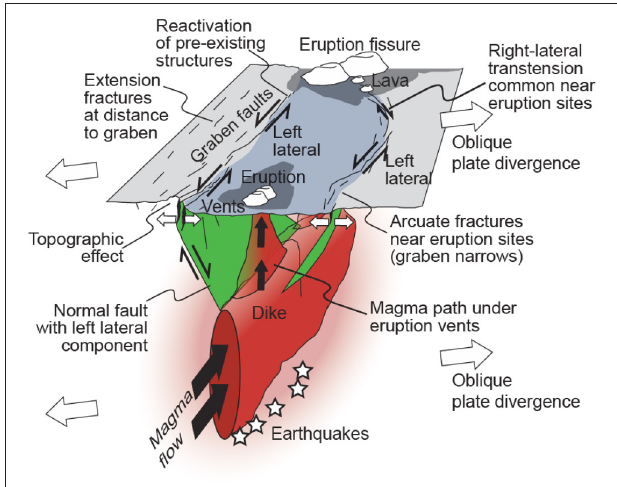
FIGURE 9 | Sketch illustrating the structural relations at the Holuhraun eruption sites. Graben subsidence is identified above the feeder dike (red color), and delimited by graben faults (green color) and smaller fractures at distance (black lines). At the surface, the graben faults show transtensional dislocations with predominantly ( > 80%) left-lateral component, which is similarly identified in seismic focal mechanisms (white star symbology) during the dike intrusion at depth ( Agustsdottir et al., 2016). Near the surface, the graben faults appear near vertical in dip, and show large slip and splays close to pre-existing topographic highs (“topographic effect”) and reactivation of other pre-existing structures and weak zones (e.g., associated with the 1797/98 vents in the north). The strike variation of graben faults show convergence toward eruption sites, yielding an arcuate expression, often associated with en-echelon arrays and step overs. This hourglass fracture convergence toward the eruption sites leads to fractures are rotated with respect to the plate divergence direction, so that they have a right-lateral component. Changes in the fault strike and formation of arcuate graben faults and an hourglass appearance close to the eruption sites are allegedly associated to a change in dike geometry at depth, either due to the presence of a locally shallower dike, or the establishment of a conduit-like magma path feeding the eruption vents, as suggested in Eibl et al.